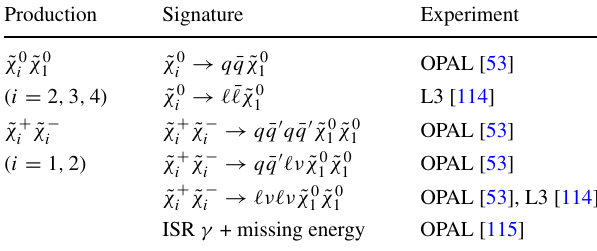
Table 2 Results from LEP on sparticle pair production used in the scans